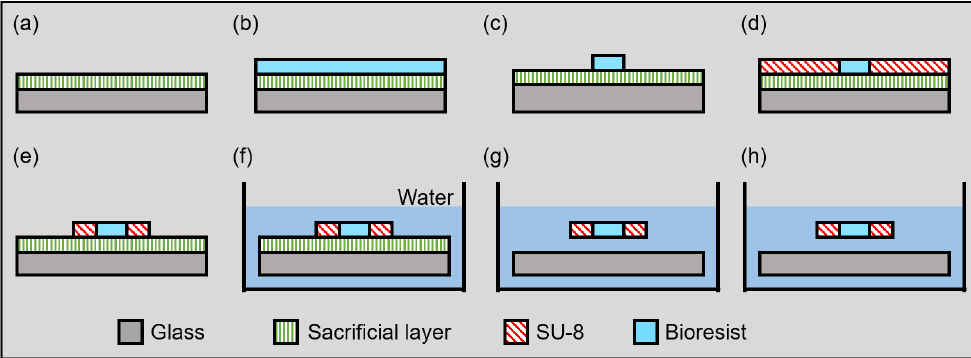
Figure 5. Fabrication process of the microgripper.